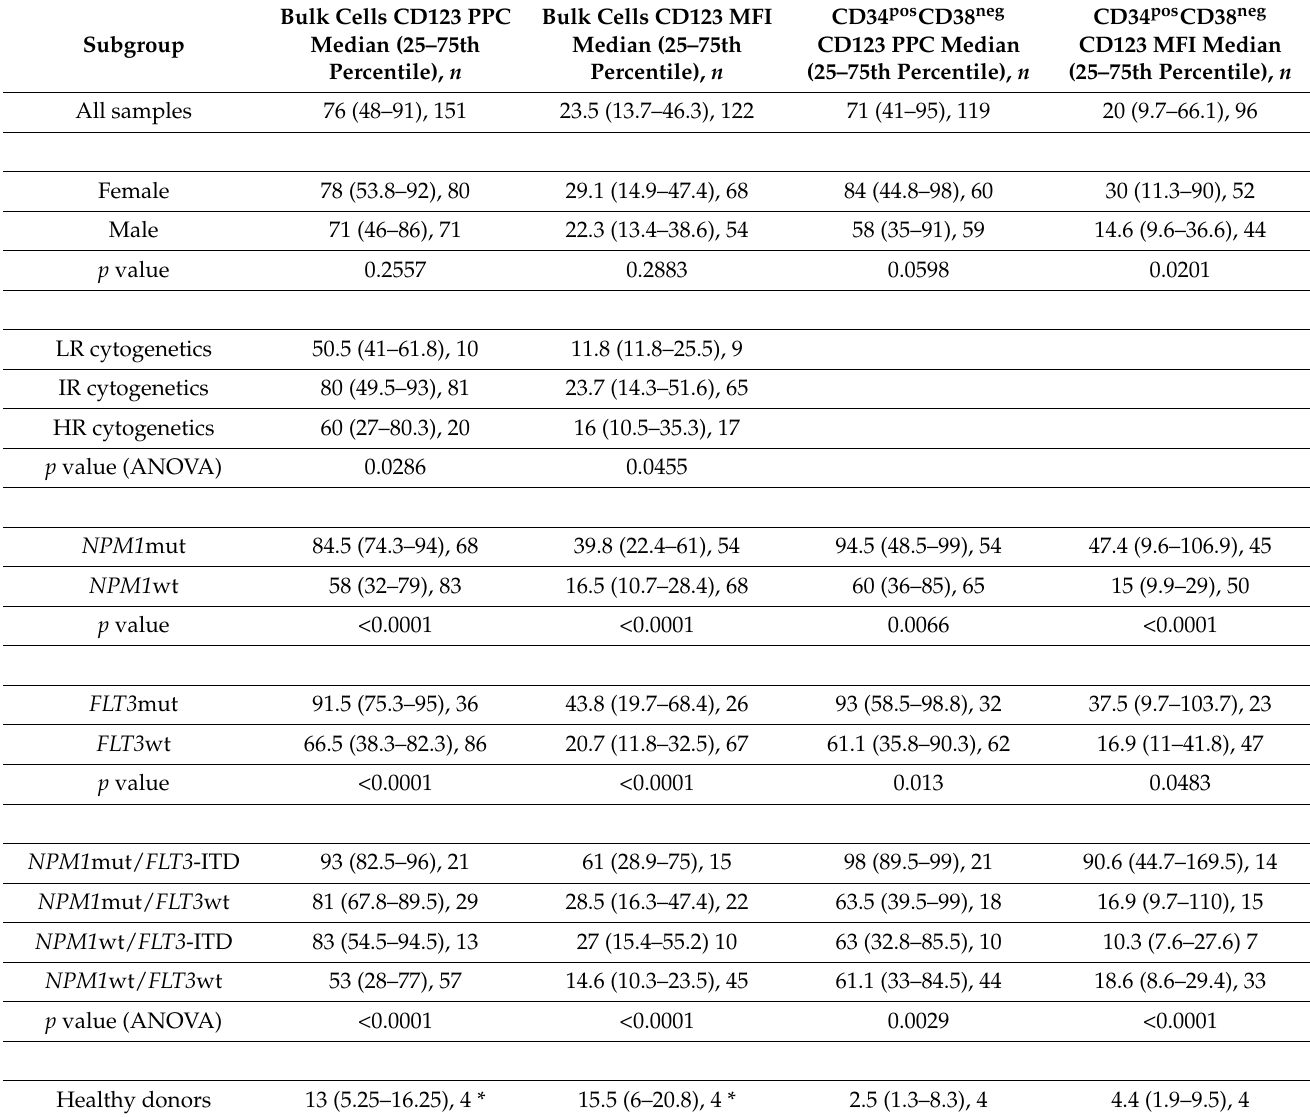
Table 1. Summary of CD123 expression in all samples. Summary of CD123 expression studied by flow cytometry in bulk acute, myeloid leukiemia (AML) and CD34 + CD38 − cells. * CD123 expression was studied in immature cells gated as CD45 dim SSC low cells (see Methods). LR, low risk; IR, intermediate risk; and HR, high risk. p -values are for unpaired t -tests, unless otherwise